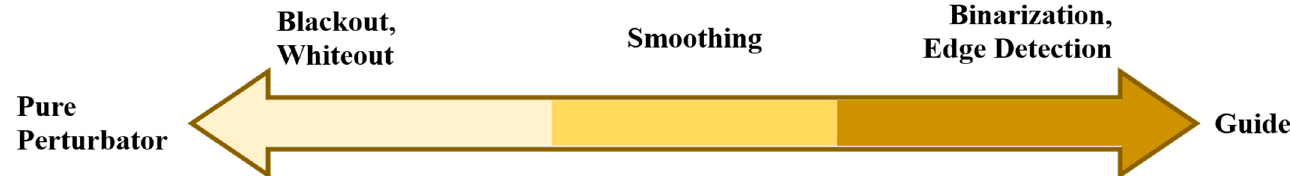
Figure 7. Attribute of perturbators. Blackout and whiteout completely erase the local information. Smoothing reduces the local information. Binarization and edge detection can guide the network to learn both the local and global